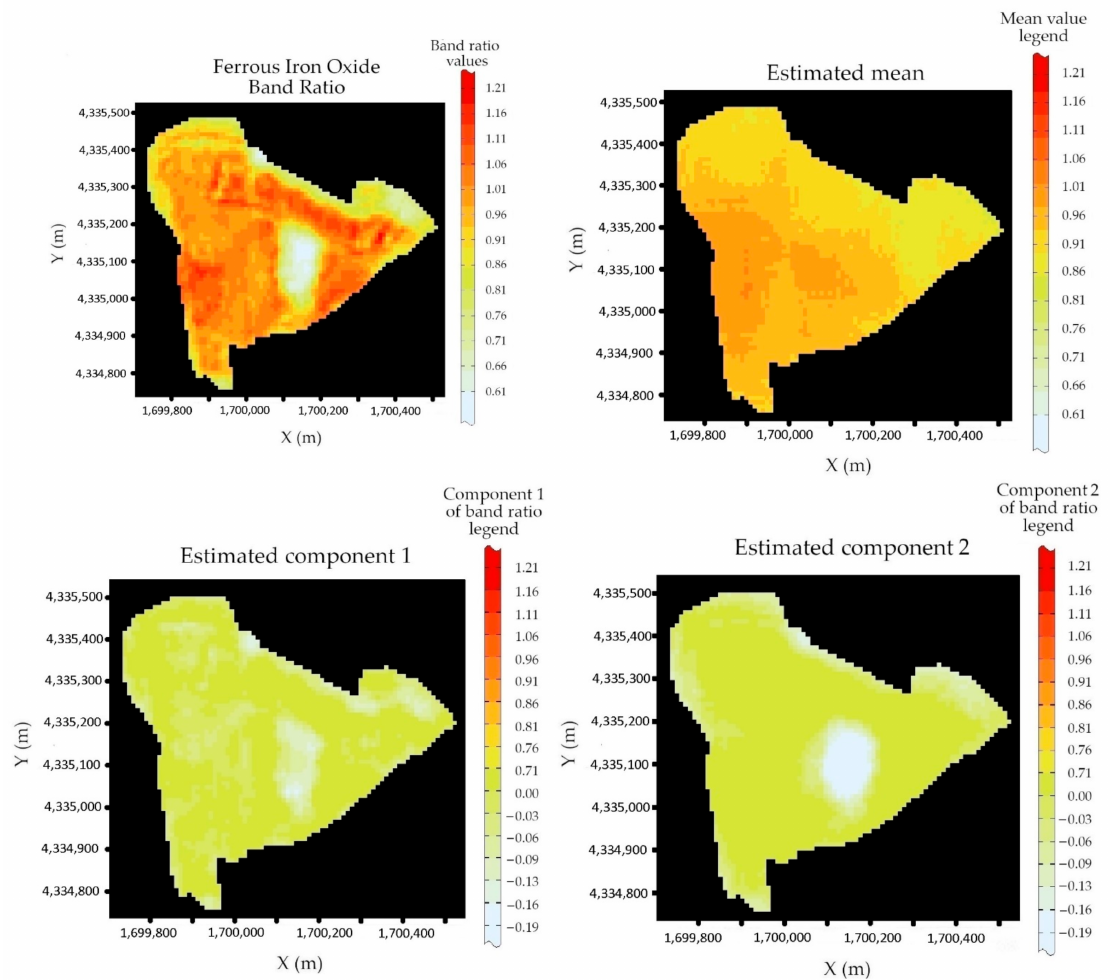
Figure 9. Base maps of real data values of ferrous iron oxides band ratios ( upper left ) and estimated components: small range component ( lower left ) and large range component ( lower right ), and the mean estimation map ( upper right ), all deposited from ferrous iron oxides band ratios.